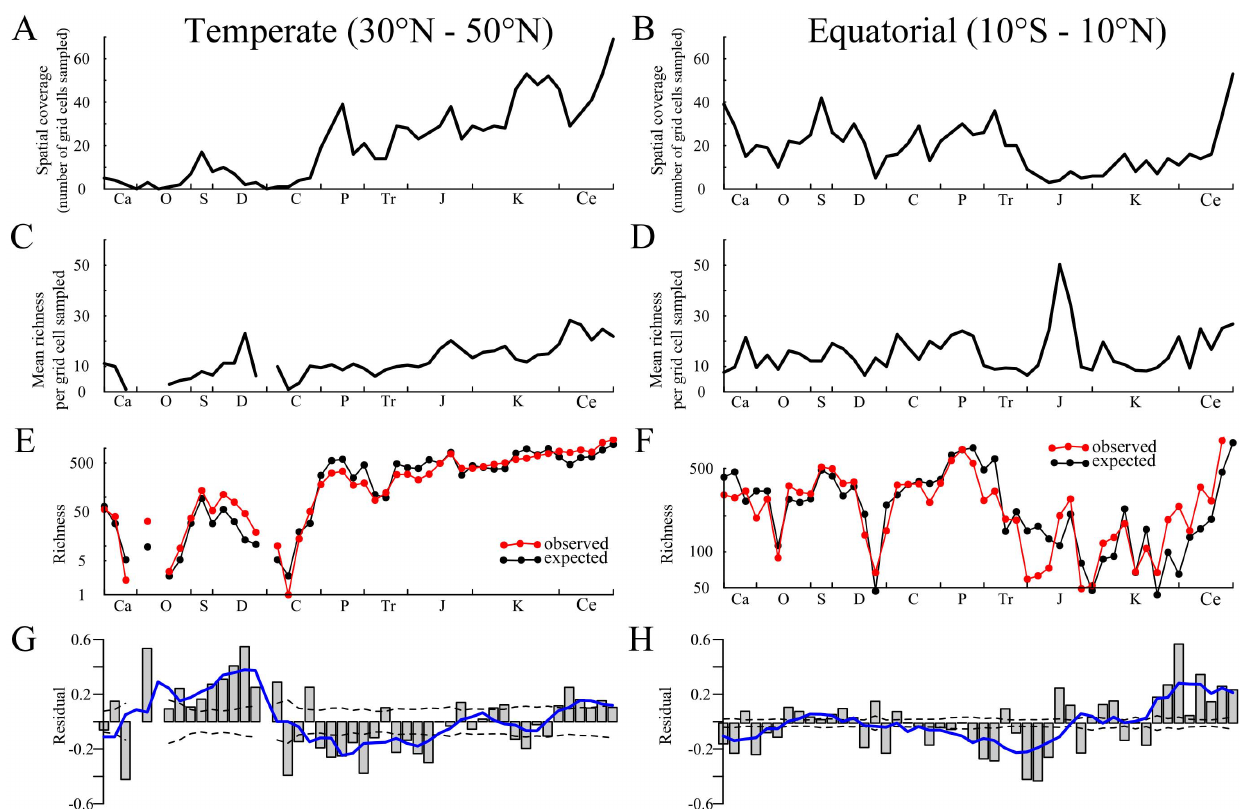
Figure 5. Diversity and sampling bias in latitude strips. A–B) Number of grid cells with sampled fossils for each time bin within two fixed paleolatiutudinal belts (temperate and equatorial). A gradual increase in sampled grid cells is evident in the temperate strip (A), while no such pattern is evident in the equatorial strip (B). C–D) Mean richness per sampled grid cell reveals no obvious pattern for faunas in the two paleolatitudinal belts. E–F) Null model that assumes biodiversity is driven purely by sampling (black) compared with observed genus richness (red). The null model explains the overall signal in the data, but select portions of the Phanerozoic deviate from the expectation. G–H) Plots show the difference between empirical richness and the expectation of the null model. Dashed bars indicate 99% confidence intervals for the null model. Overall, we find that the temperate and tropical faunas have similar trajectories despite markedly different trends in spatial sampling pattern over time.